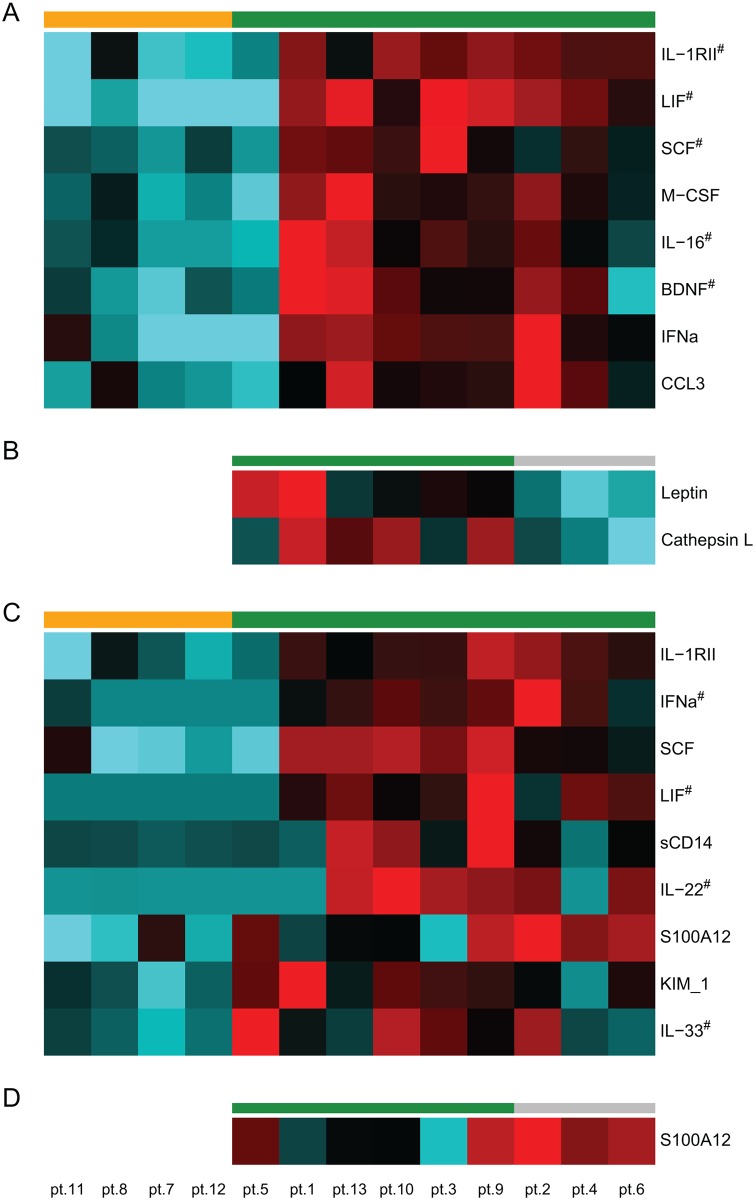
Serum marker levels before or after islet transplantation that could differentiate between good and poor graft function.Heatmap representation of significantly different serum markers between patients with good graft function (green) and patients with poor graft function (orange) before (A&B) or 1 year after (C&D) transplantation (Student’s t-test, p<0.05). In the group of patients with good graft function, those with continued insulin independence (green) and temporary insulin independence (grey) were subdivided (B & D). Heatmap gradient represents min to max (cyan—black—red) normalized serum titers.